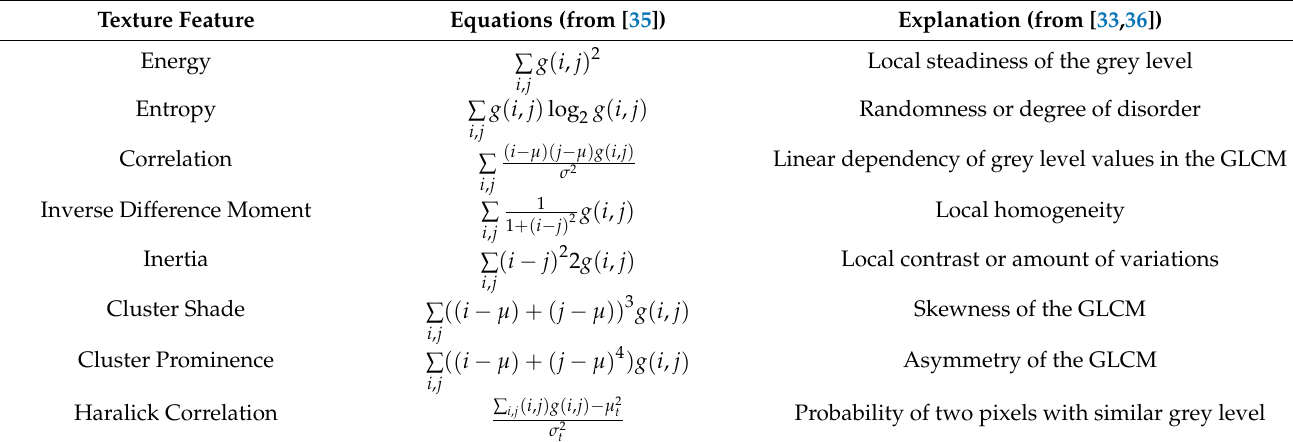
Table 2. Haralick texture features computed over sliding windows with user defined radius. g(i,j) is the element in cell i, j of a normalized Grey Level Co-occurrence Matrix